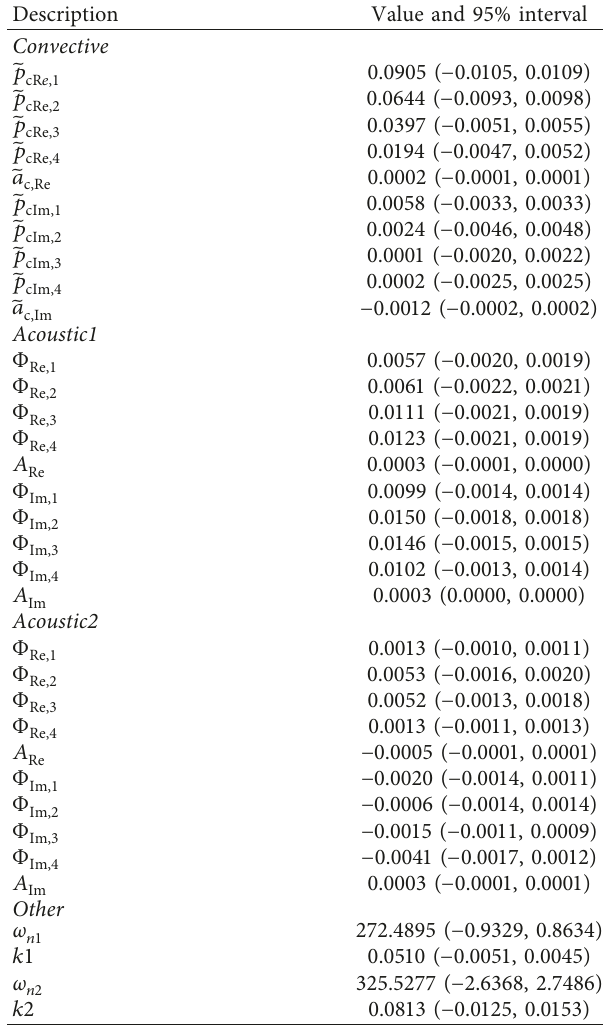
Table 4: Fitting